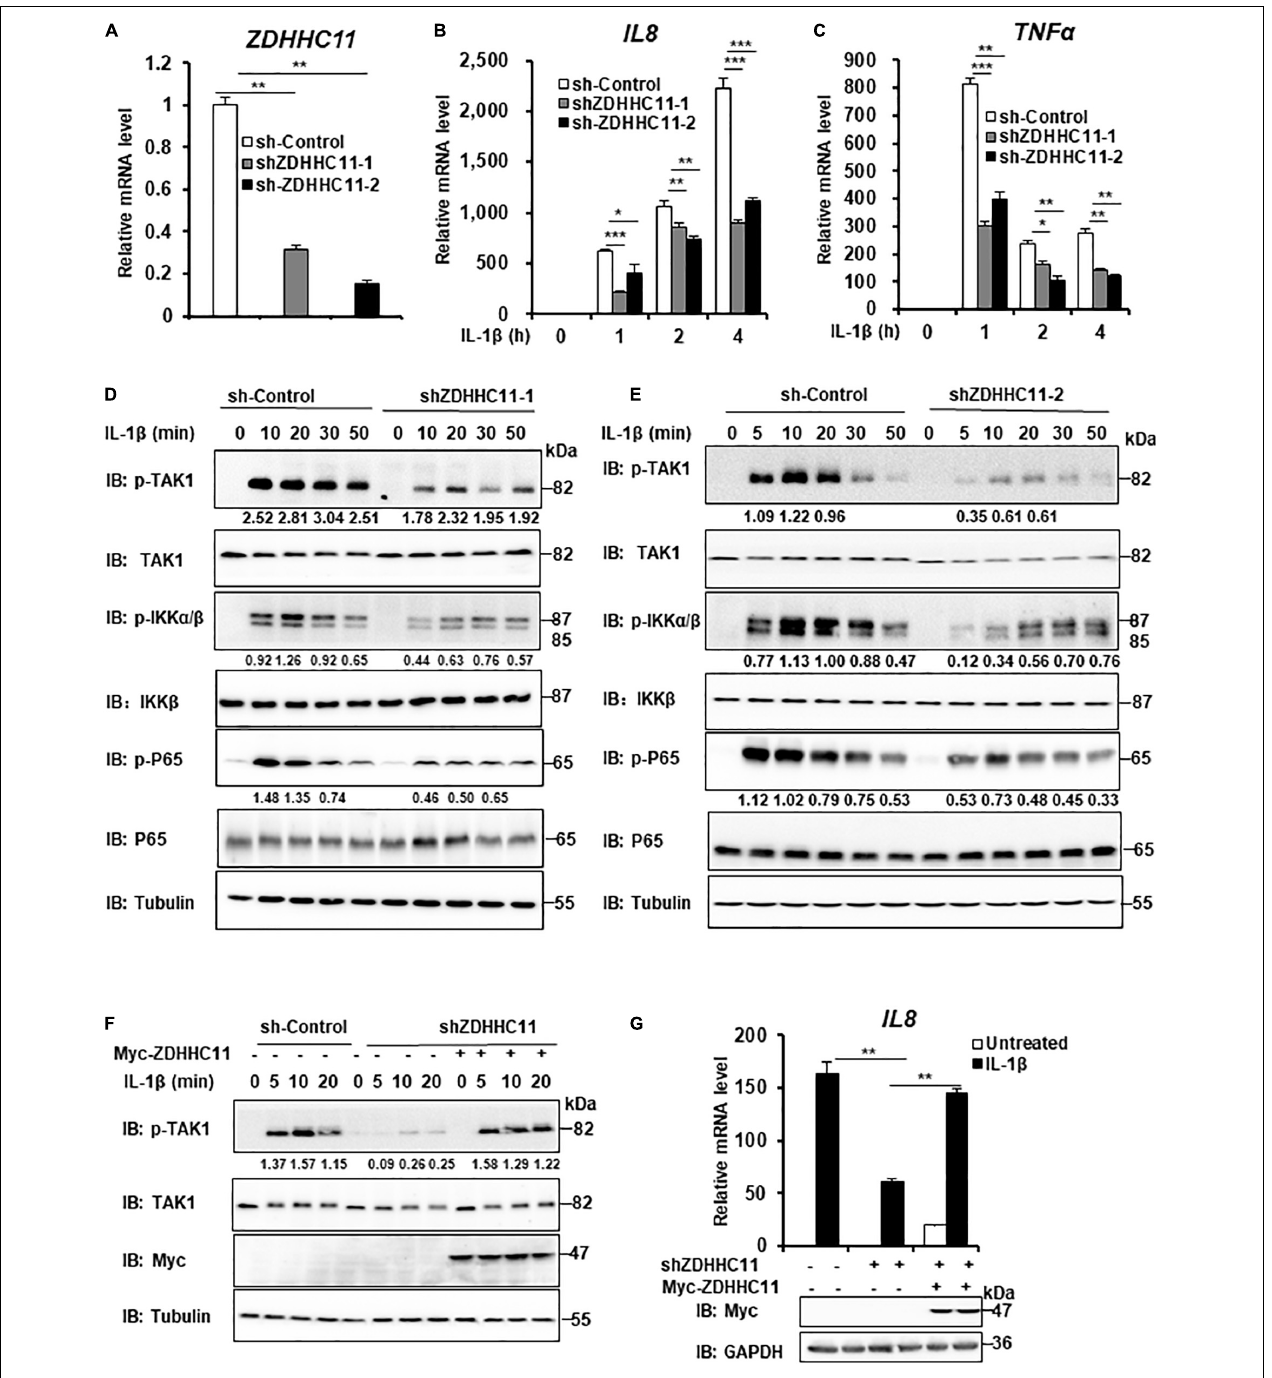
FIGURE 2 | ZDHHC11 knockdown attenuates IL-1 β -induced NF- κ B activation. (A–C) HEK293 C6 cells were infected with lentivirus expressing shRNA that targeted different coding regions of human ZDHHC11 (shZDHHC11-1 and shZDHHC11-2) or an empty vector for 48 h and then unstimulated or stimulated with IL-1 β (10 ng/ml) for the indicated times. qRT-PCR assays were performed to examine the mRNA levels of ZDHHC11 (A) , IL8 (B) , and TNF α (C) . (D,E) Infection was performed as described in (A) . The cells were unstimulated or stimulated with IL-1 β (10 ng/ml) for the time as indicated. Cells were harvested to perform immunoblot assay. (F) HEK293 C6 cells were infected with lentivirus expressing shRNA that targeted ZDHHC11 or an empty vector for 48 h and then transfected with a ZDHHC11 expression plasmid (500 ng) or empty vector as indicated. After 24 h of transfection, the cells were simulated with IL-1 β (10 ng/ml) for the indicated times, followed by immunoblot analysis. (G) HEK293 C6 cells were infected and transfected as described in (F) and then treated with IL-1 β for 3 h, followed by qRT-PCR analysis. Data shown in (A–C,G) are representative of three independent experiments (mean ± SD of duplicate experiments). * P < 0.05; ** P < 0.01; *** P < 0.001 versus the control groups; and Student’s t -test. All blots are representative of three independent experiments.